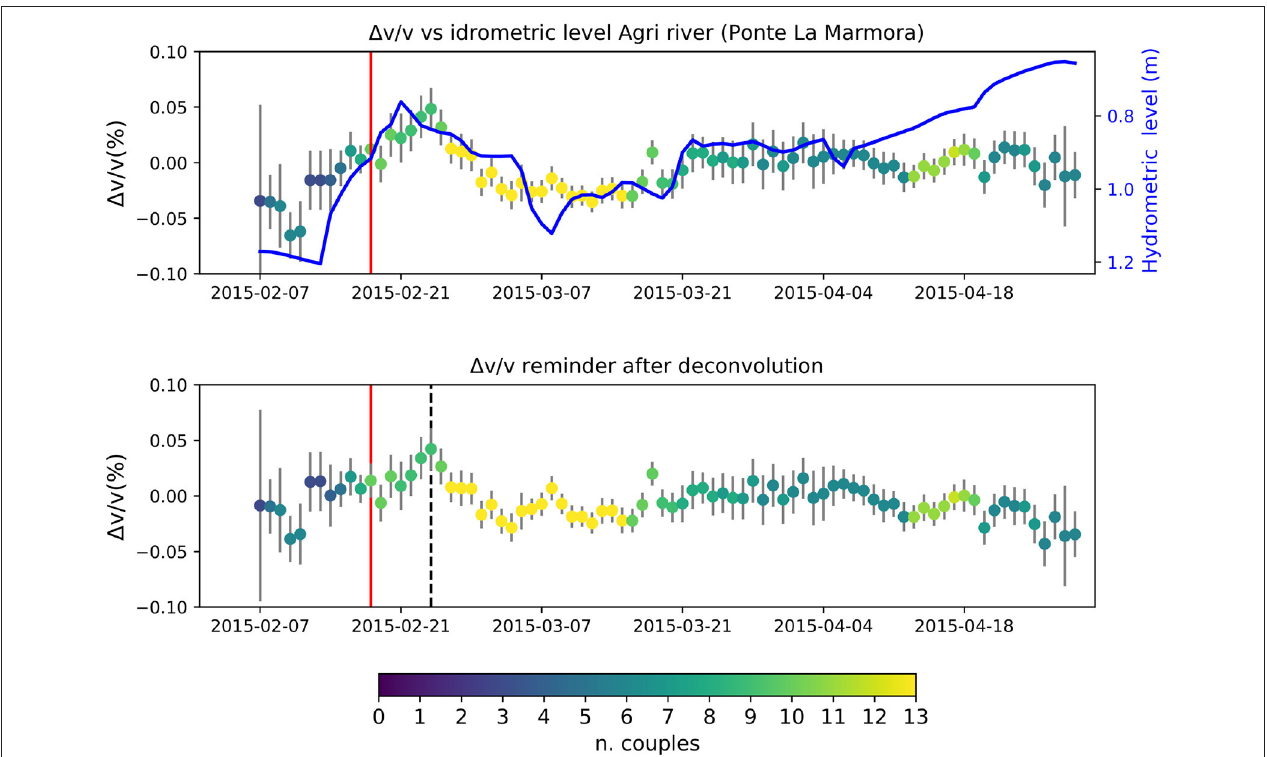
FIGURE 9 | (Top) Percentual crustal velocities variations as a function of time (dots) compared to the idrometric level of the Agri river (blue line, reversed y axes). (Bottom) Percentual crustal velocities variations after removing the Agri river idrometric level. Red line: produced water injection restart. Black dotted line: dv/v